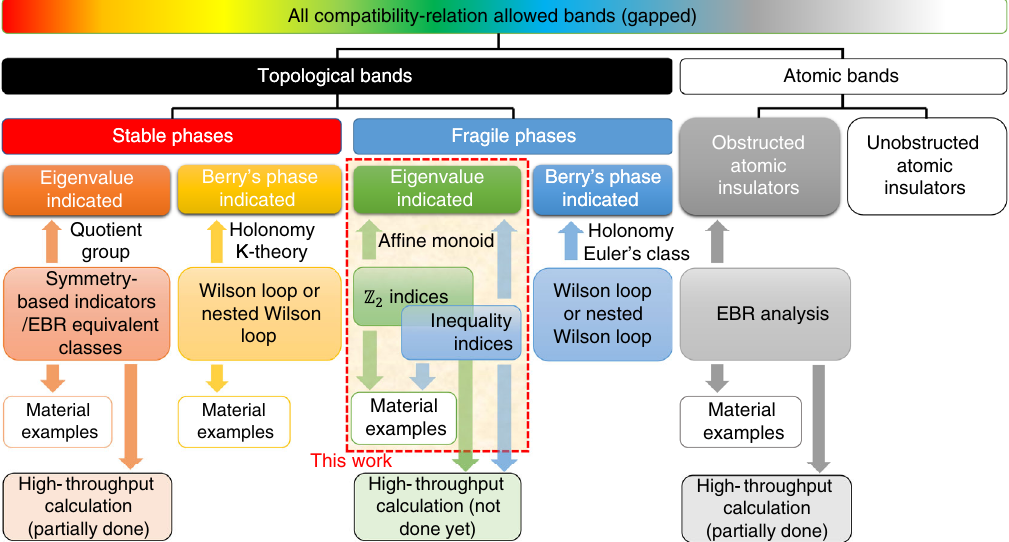
FIG. 1. The classification of topological bands, where the shaded area represents the contents of the present work. All the band structures are classified into three categories: stable topological bands, fragile topological bands, and atomic (trivial) bands. The stable or fragile topological bands are further classified into two subcategories: those indicated by symmetry eigenvalues and those not indicated by symmetry eigenvalues. The atomic bands are also classified into two subcategories depending on whether the Wannier functions are located at the positions of atoms. The topological states that are not eigenvalue indicated are usually identified by the Wilson loop method [30,52 – 55], but the general framework to calculate their topological invariants is still unknown. The eigenvalue-indicated stable topological states are classified by the TQC [37] and other theories [38,50]. The present work finishes the classification of